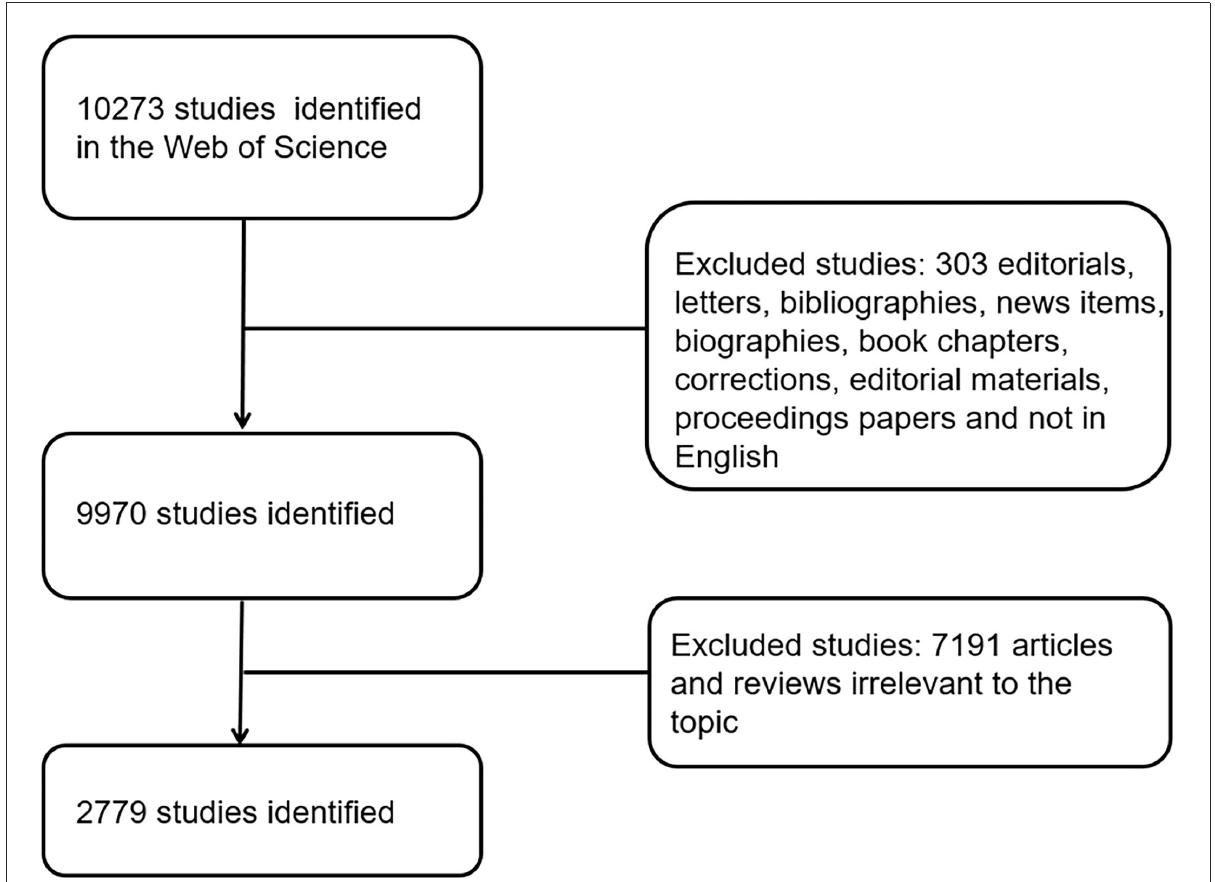
FIGURE1 Flow diagram of the inclusion process. The detailed process of screening and enrolment (irrelevant articles were manually screened by two authors through abstracts and full texts, and articles irrelevant to the topic were